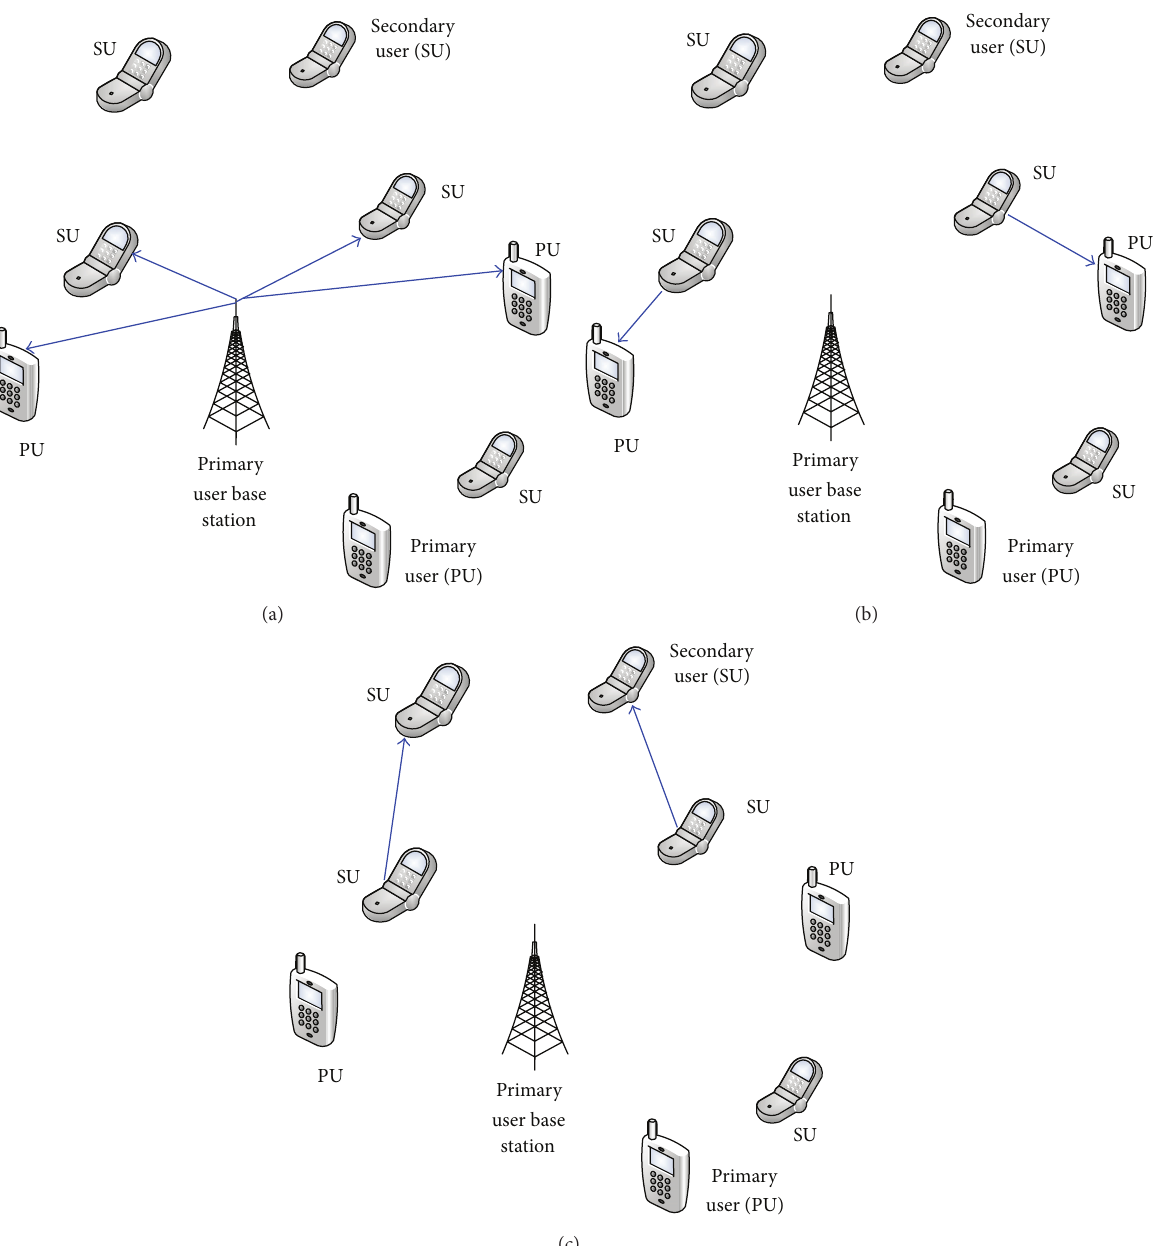
Figure 1: Conceptual diagram of the system model.